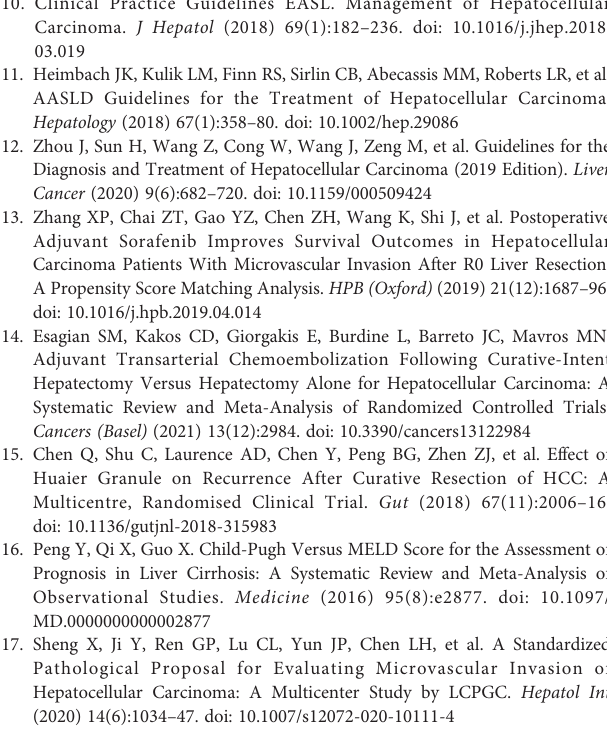
Supplementary Figure 1 | Flow Chart of patient ’ s